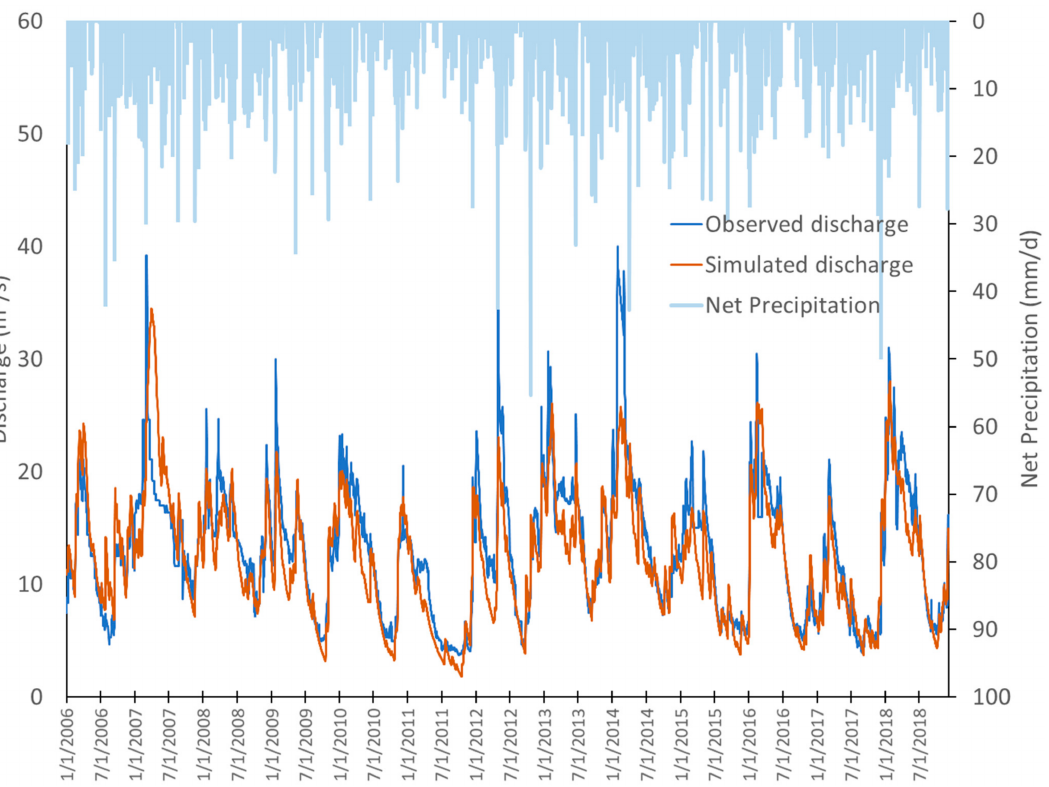
Figure 2. Comparison between observed, simulated and natural discharge at the outlet of the Touvre karst aquifer over the entire period (month/day/year).